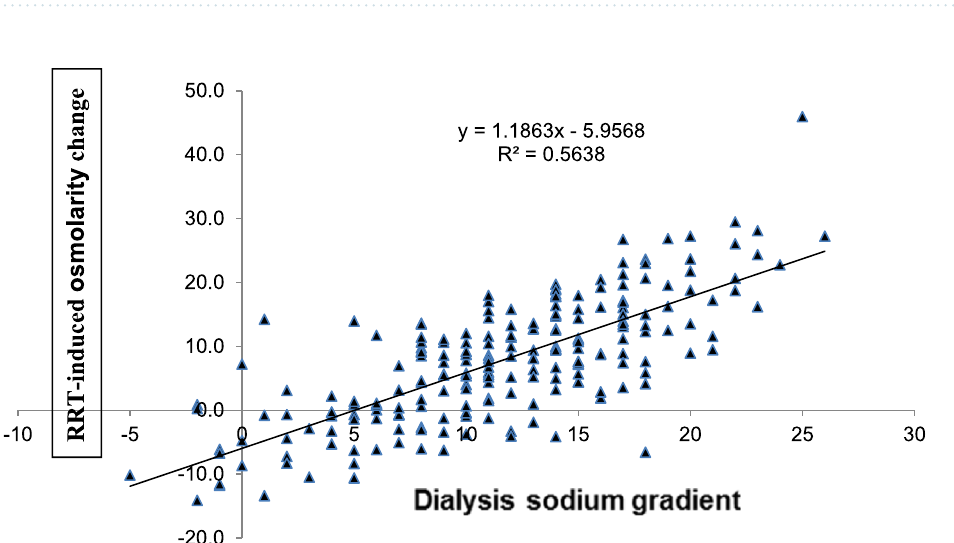
Figure 3. Correlation between the dialysate sodium gradient and the RRT-induced change in serum osmolarity (Pearson’s r 2 ,